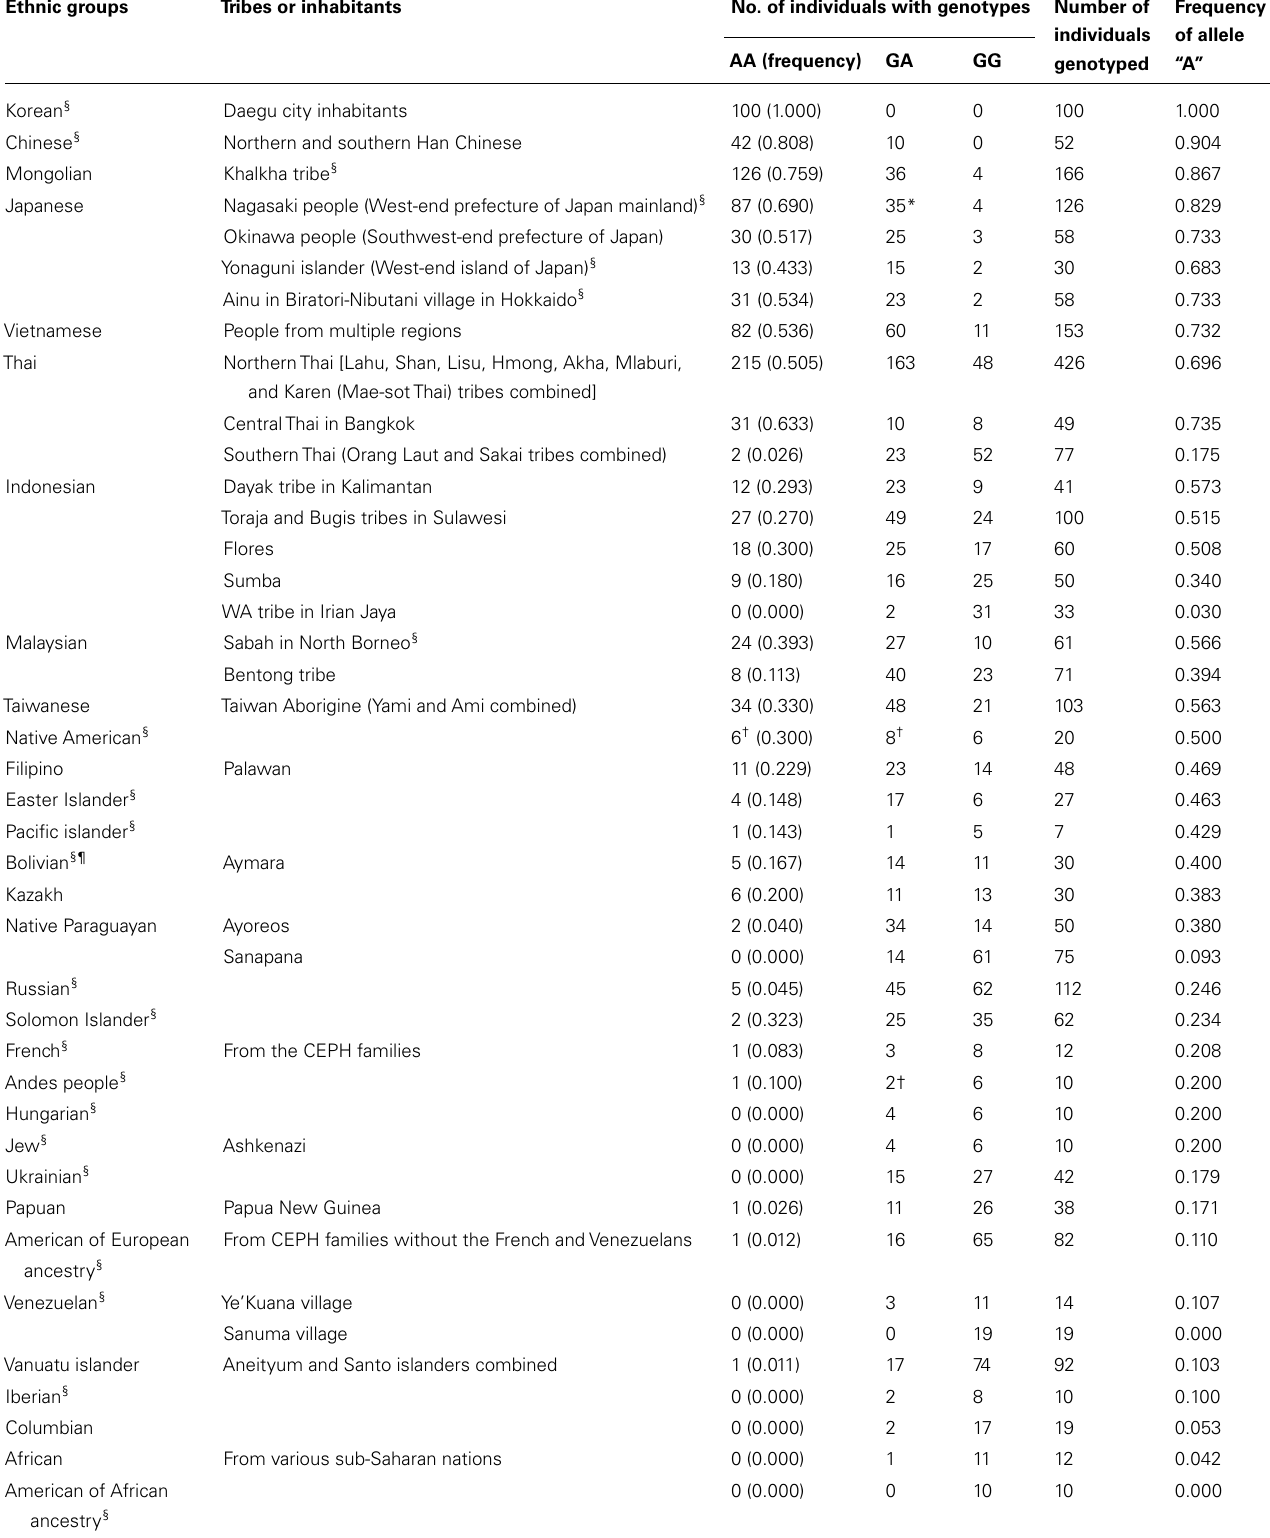
Table 2 | Frequencies of ABCC11 genotypes and allele c.538A among different ethnic groups. Ethnic